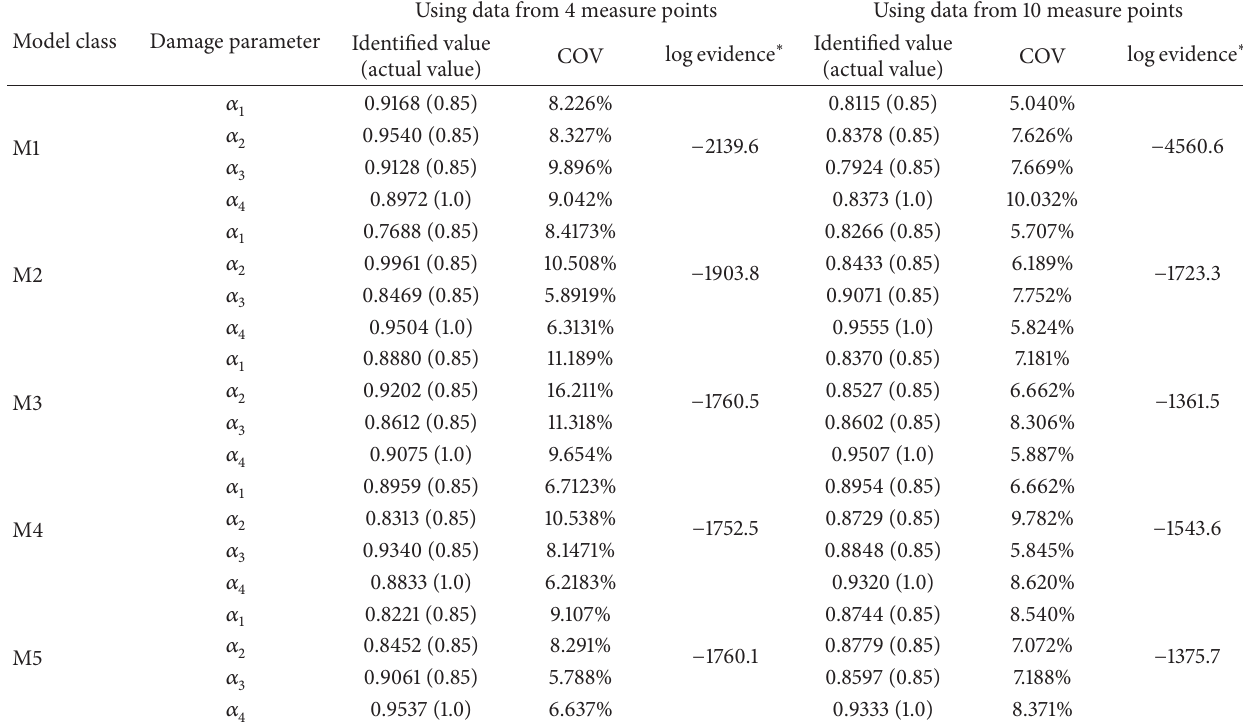
Table 5: Identified damages based on five model classes with two measurement schemes. Model